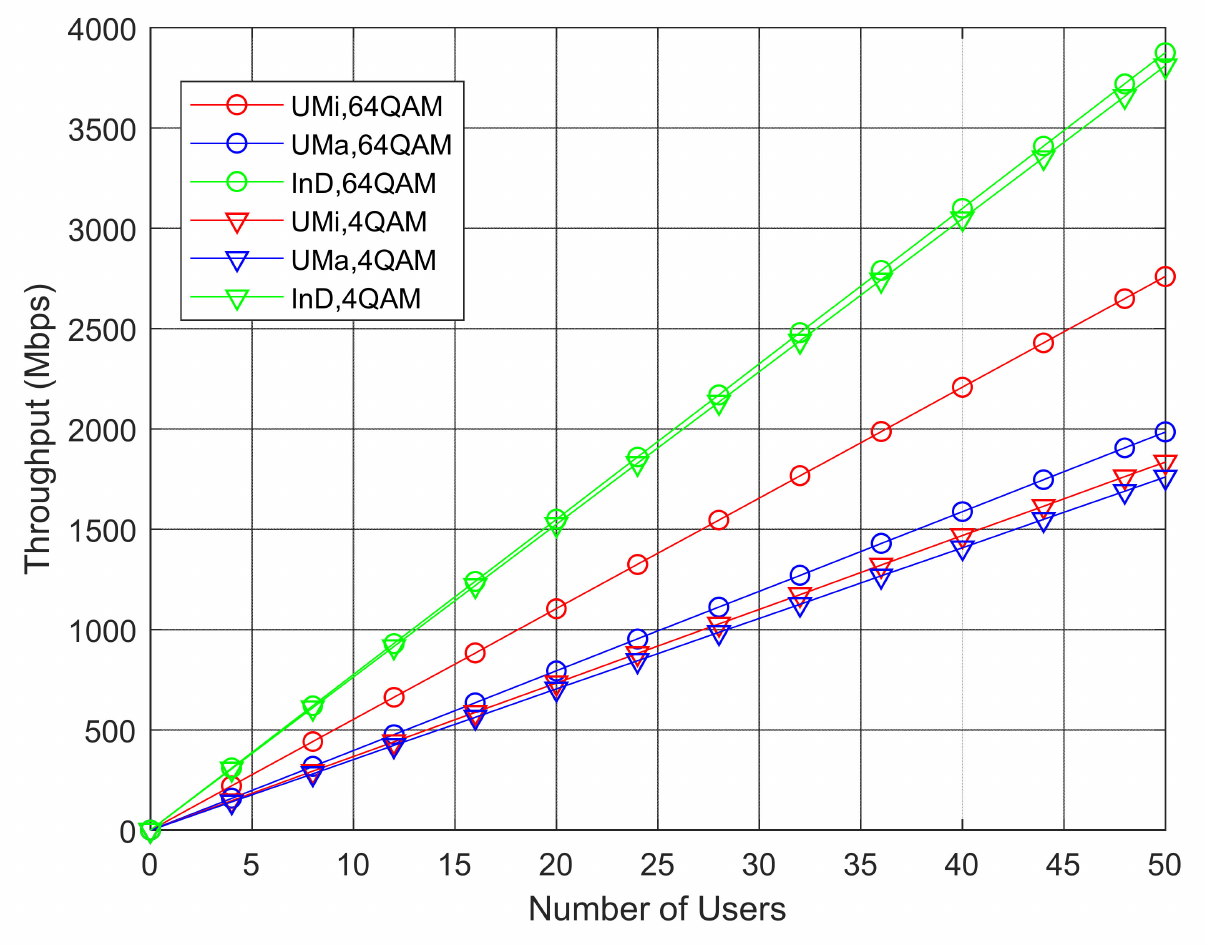
Figure 7. Throughput vs. number of users for different scenarios with N tx = 5 N u , N f = 4, N af = 3, N s = 5, N a = 2, N rx = 5, 64-QAM (11.75 bpcu per user) and 4QAM (5.75 bpcu per user), C-RAN cluster size